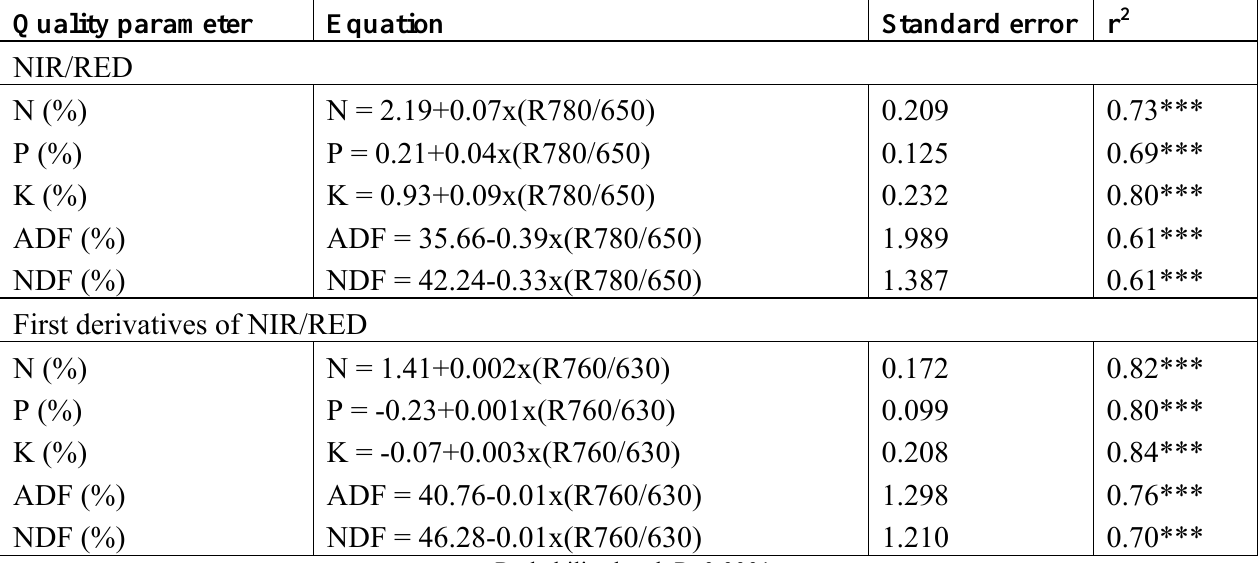
Table 2. Relationships between NIR/RED ratio and nutrition contents in sainfoin pasture.